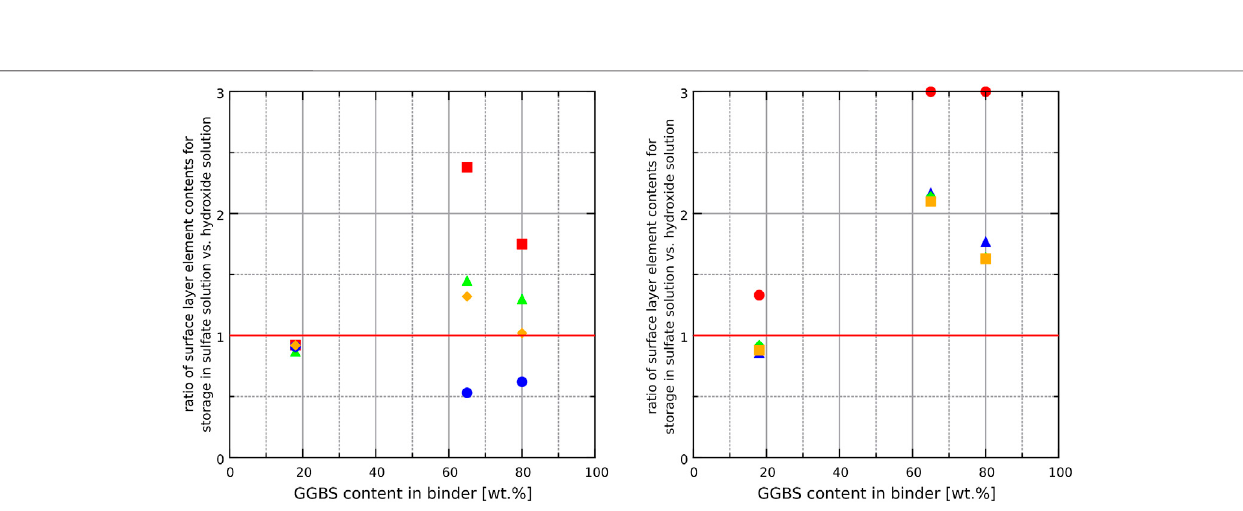
FIGURE5| EffectofGGBScontentinthebinderontheratiosofelement contents(measured byICP-OES) withinthe surfacelayerofhardenedbinder pastes after storageinthesodiumsulfatetothoseofthecalciumhydroxide solution.Aratio > onemeansthatthecontentofanelementinthesurfacelayerishigher forstorageinthe sodium sulfatesolution.Mostminor elementsarehigher concentratedonbindersurfacesthathavebeenexposedtosodium sulfatesolutionforbinderswithhighGGBS concentrations (65_SO4 and 80_SO4). Left fi gure: Al ( ▲ ), Mg ( ■ ), Ca ( C ), Si ( ◆ ). Right fi gure: Ti ( ▲ ), Ba ( C ), Mn ( ◆ ), Fe ( ■ ).